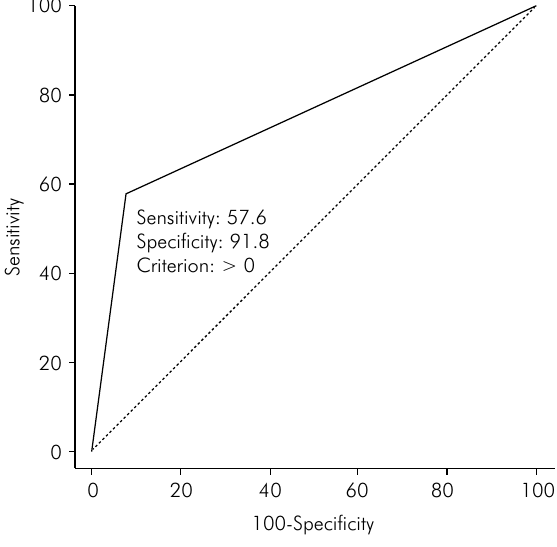
Figure 2. ROC curve for sampling methods of subgingival plaque by sterile curette and by sterile paper points.